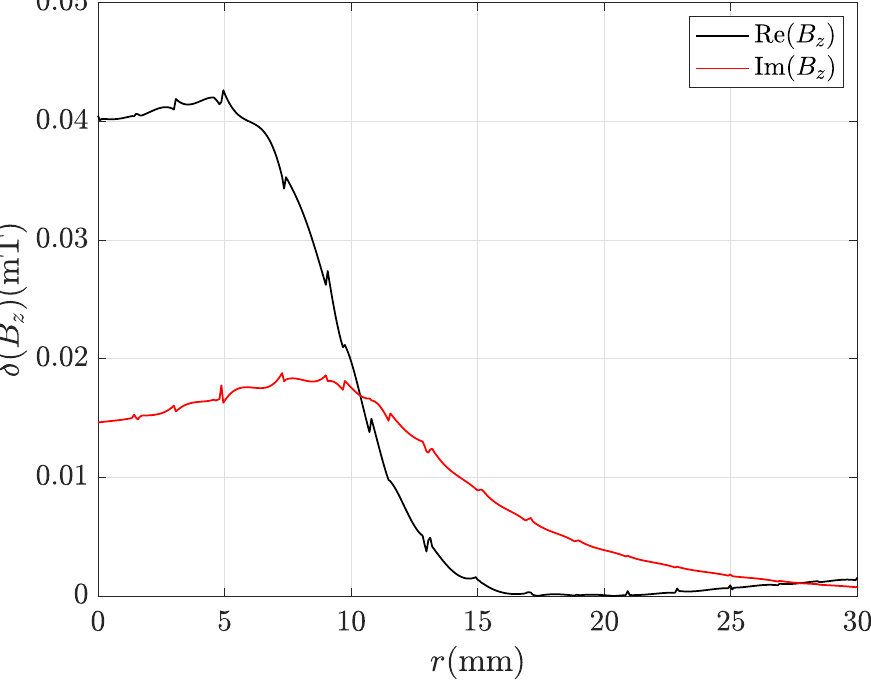
Figure 7. Local discrepancy between CM-BEM and FEM profiles of component B z in Figure 5. Table 6. Discrepancy between 3D CM–BEM with R-SVD compression and third ord. 2D